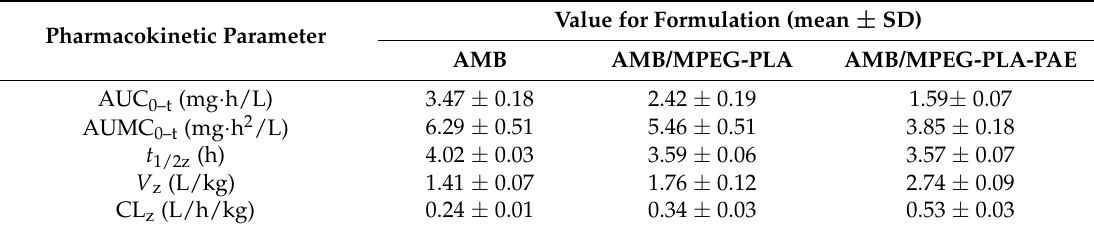
Table 2. Pharmacokinetic parameters of various AMB formulations (1